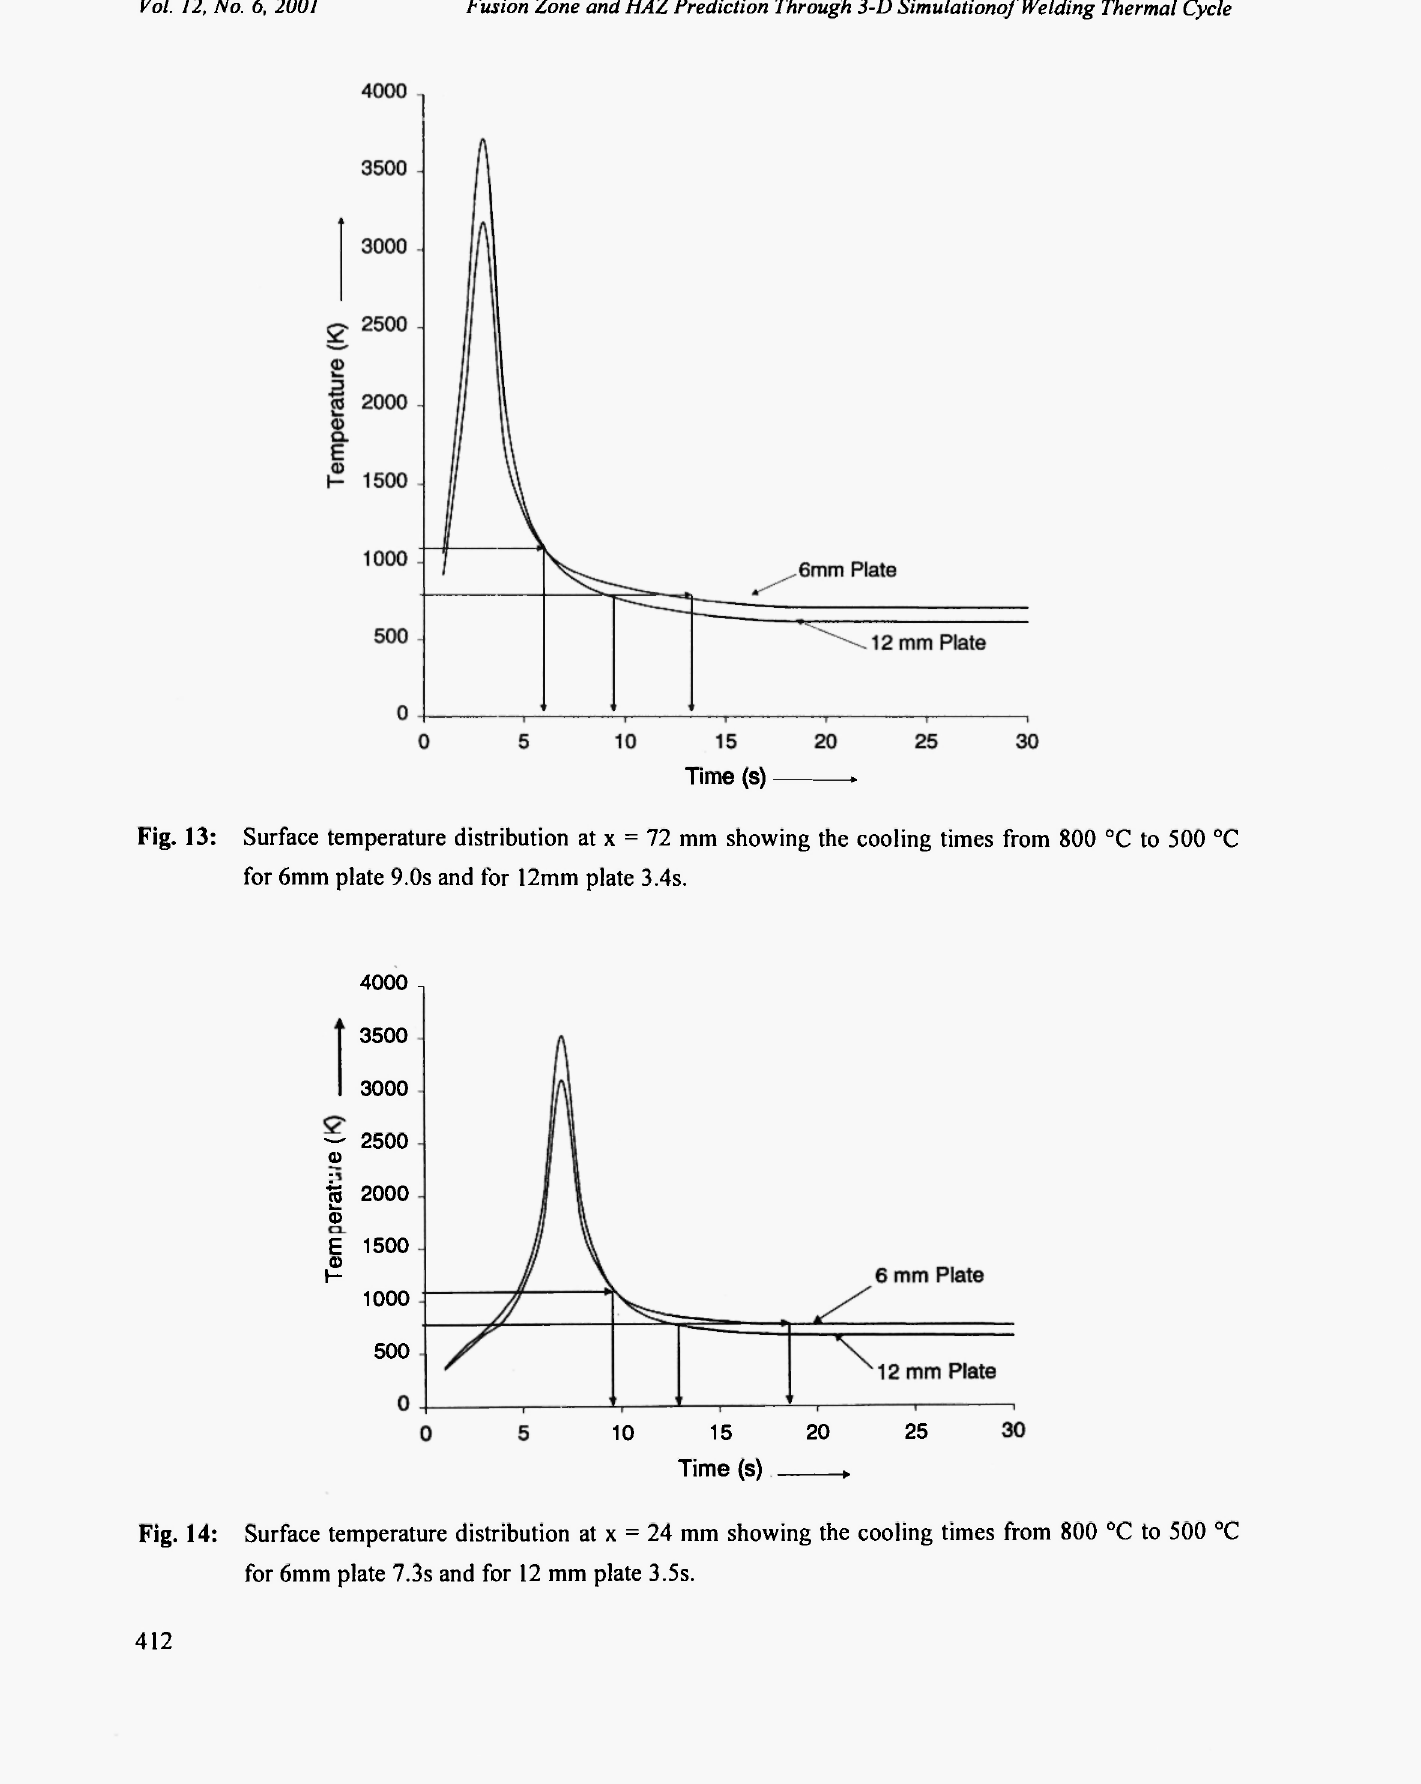
Fig. 13: Surface temperature distribution at χ = 72 mm showing the cooling times from 800 °C to 500 °C for 6mm plate 9.0s and for 12mm plate 3.4s.